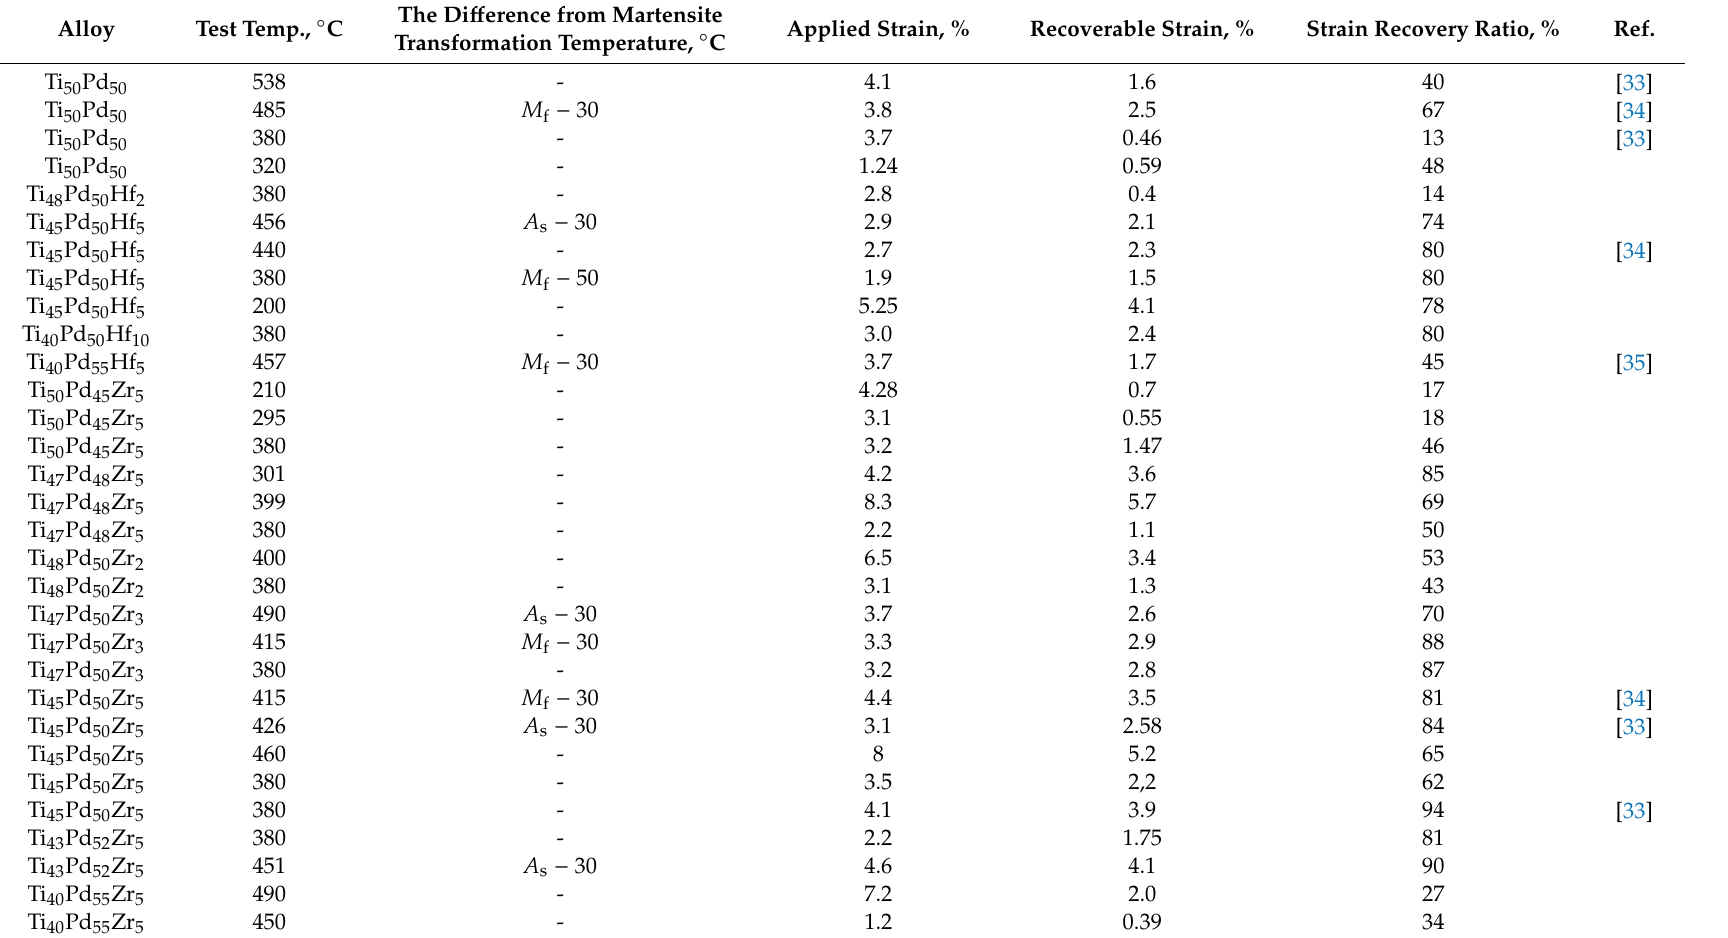
Table 4. Strain recovery of ternary